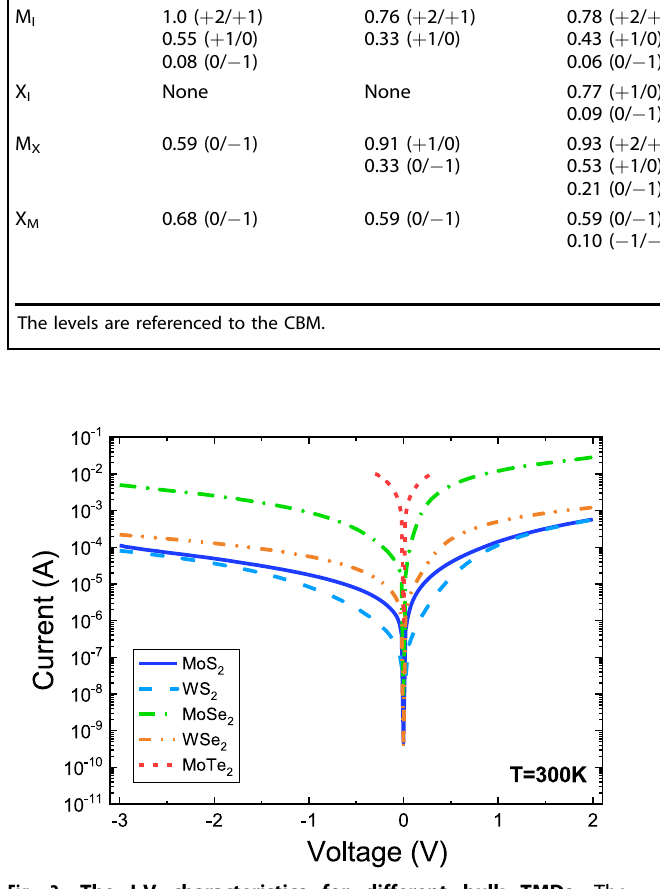
Fig. 2 The I-V characteristics for different bulk TMDs. The measurements were performed at 300 K under identical bias conditions, i.e., from – 3 V to + 2 V range and 10 mA current